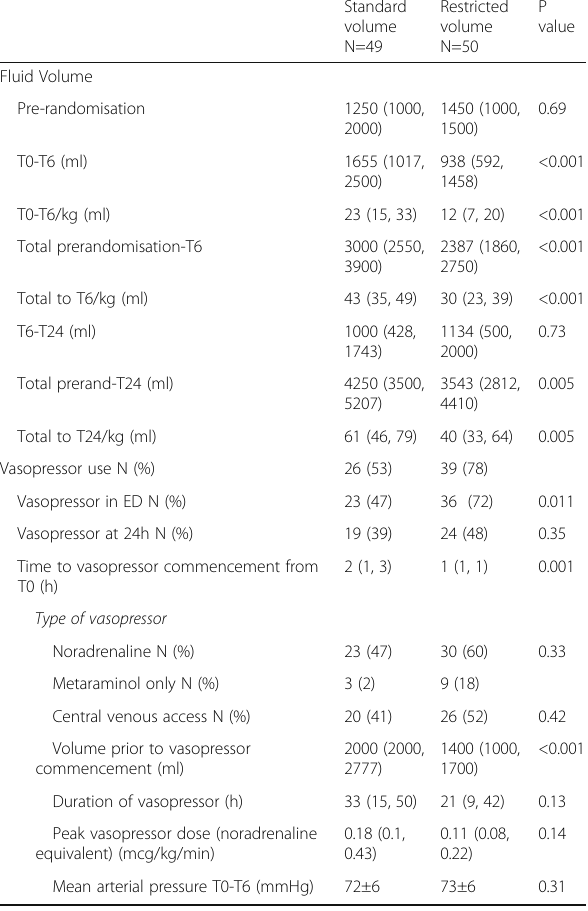
Table 2 (abstract P21). Fluid and vasopressor use. Values are median (interquartile range) unless otherwise stated. T0 -randomisation; T6 – 6 hours post-randomisation; T24 – 24h